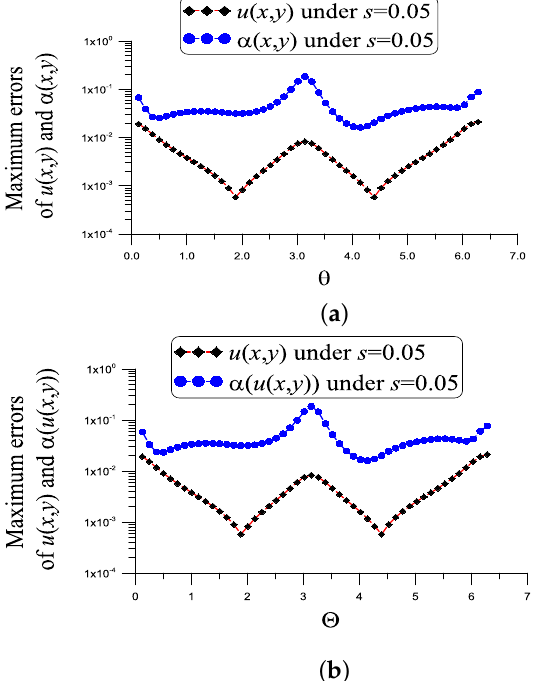
Figure 2. For example 1, showing the errors in the numerical recovery of u and α under a noise s = 0.05, ( a ) Q = 0 and ( b ) Q = u 2